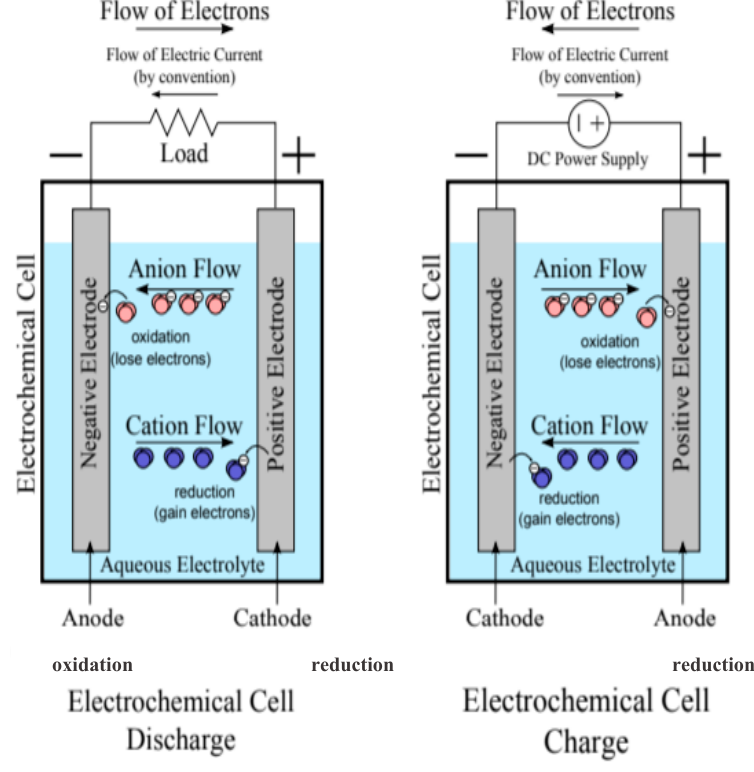
Figure 7. A typical charge and discharge cycle of an electrochemical battery cell [56].